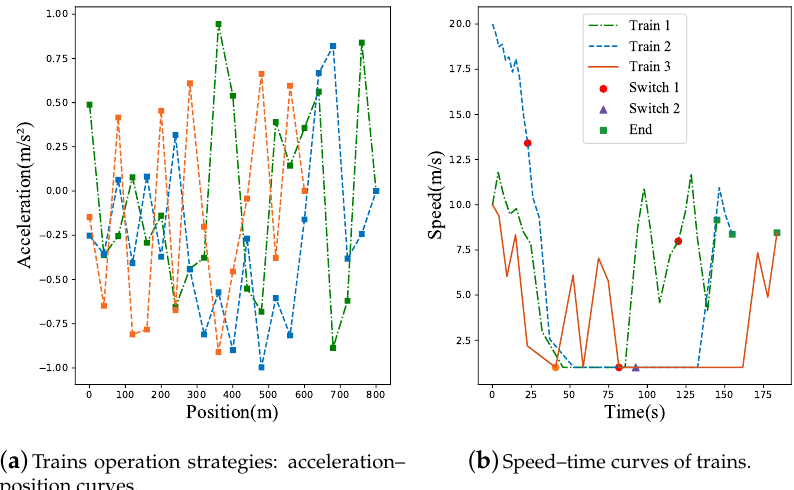
( a ) Trains operation strategies: acceleration– position curves. Figure 5. Unimproved PSO strategies and operation curves in scenario